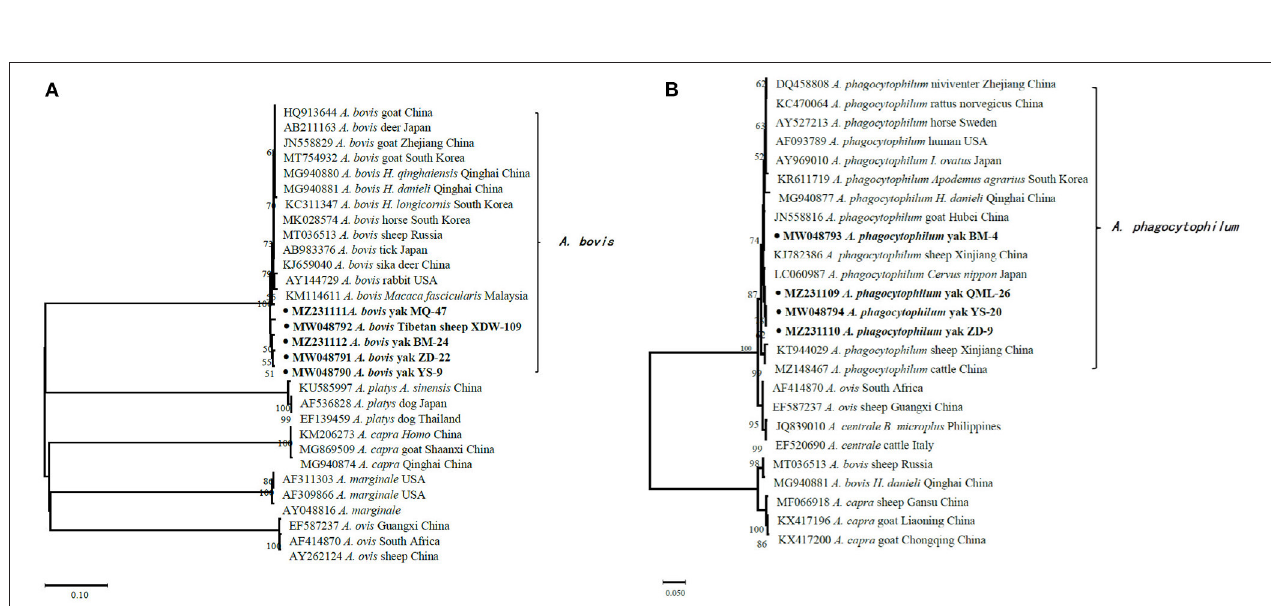
FIGURE 2 | Phylogenetic trees were constructed based on partial sequences of the 16S rRNA genes of A. bovis (A) and A. phagocytophilum (B) . Phylogenetic trees were con-structed by the neighbor-joining method with the p-distance model using the MEGA X software, and the bootstrap test was assessed with 1,000 replicates. The species identified in this study are indicated by • and highlighted in